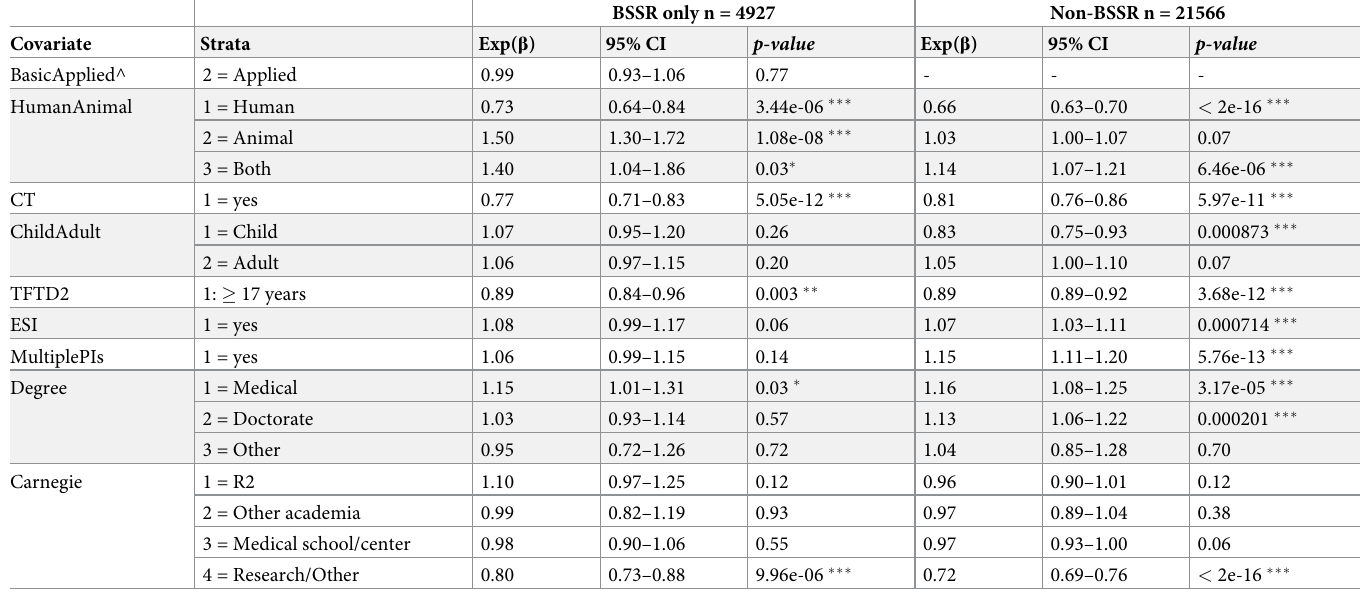
Table 3. Full Cox regression models stratified by BSSR or